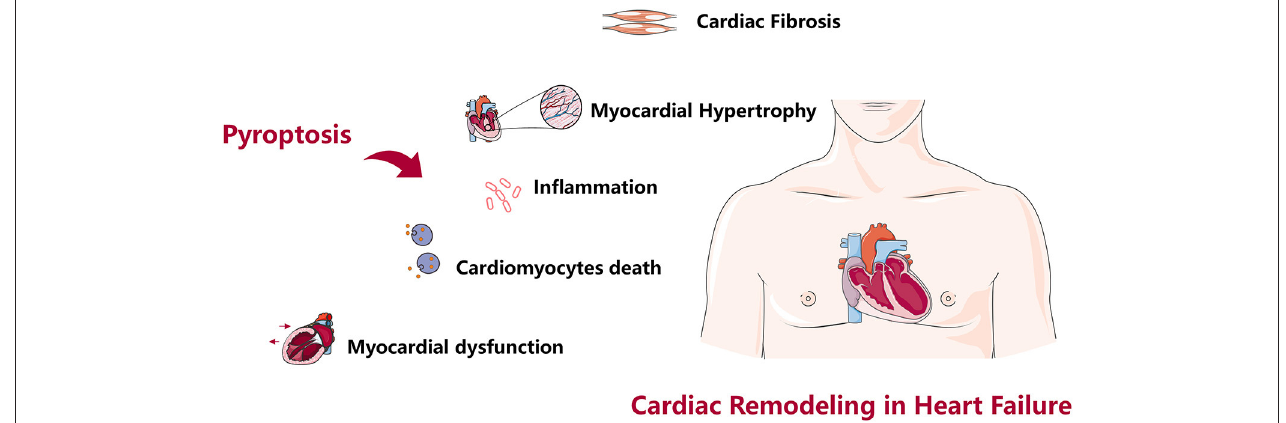
FIGURE 2 | Role of pyroptosis in cardiac remodeling. Pyroptosis causes cardiac fibrosis, cardiac hypertrophy, cardiomyocytes death, myocardial dysfunction, excessive inflammation, and cardiac remodeling in heart failure. mouse, and echocardiography demonstrated that the left ventricular internal dimension and left ventricular volume were also decreased by inhibition of RBP4, indicating attenuated adverse cardiac remodeling. Importantly, knockdown of RBP4 significantly improved AMI-induced decrease of left ventricular ejection fraction and fractional shortening